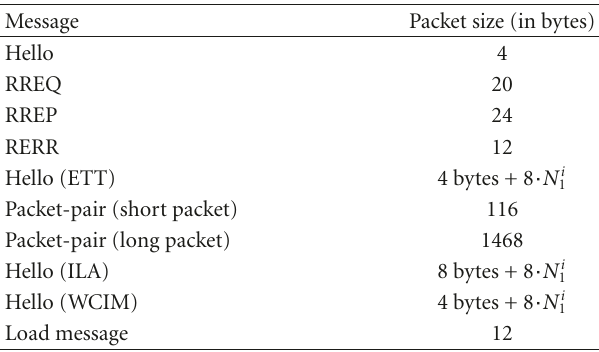
Table 4: Control messages of